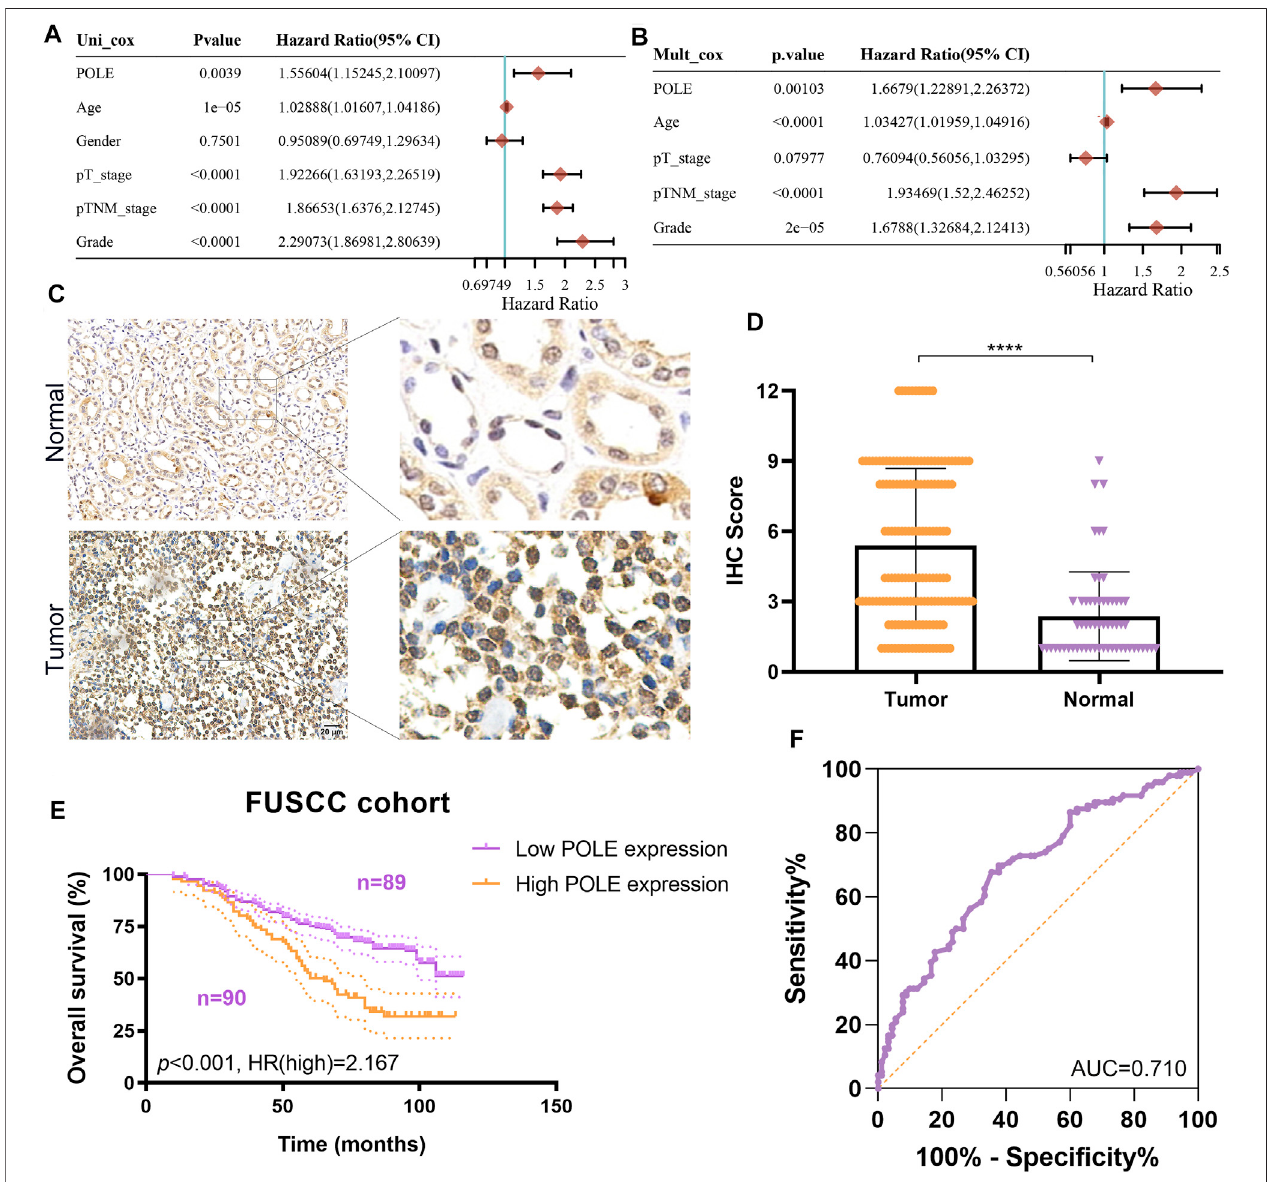
FIGURE 6 | Validation of differential polymerase epsilon (POLE) expression and its prognostic value in the Fudan University Shanghai Cancer Center (FUSCC) cohort. (A,B) Univariate and multivariate Cox regression analyses was performed to reveal independent prognostic value of POLE expression for the outcomes of patients with ccRCC. (C) IHC analysis of samples from the FUSCC cohort showing that the expression of POLE was signi fi cantly higher in ccRCC than in normal kidney tissues. (D) TheIHC scoresofPOLEexpression inccRCC tissuesand normal tissues . (E) Prognosticimplications ofPOLEexpressioninpatientswith179ccRCC in the FUSCC cohort. (F) ROC curve indicating the sensitivity and speci fi city of the independently diagnostic and prognostic value of POLE expression.